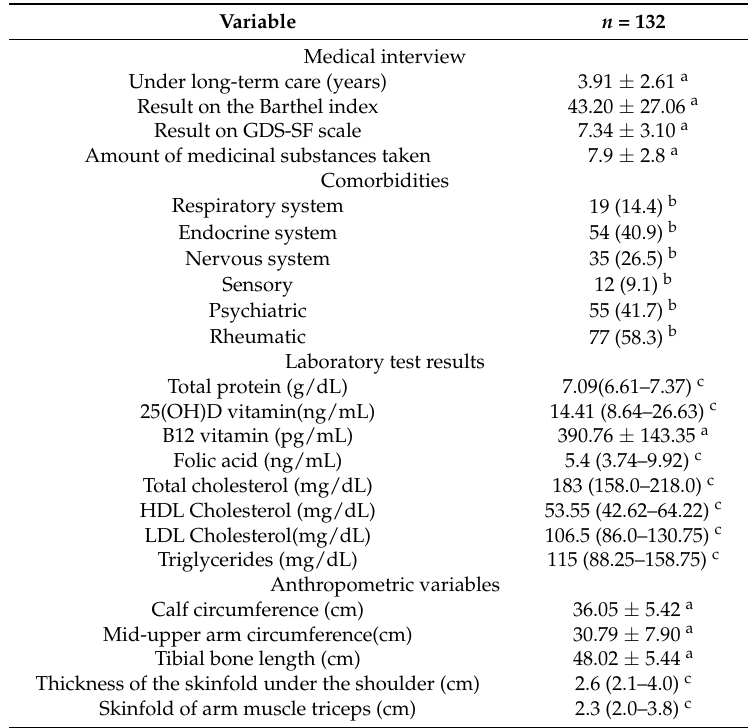
Table 1. Characteristics of the examined group.